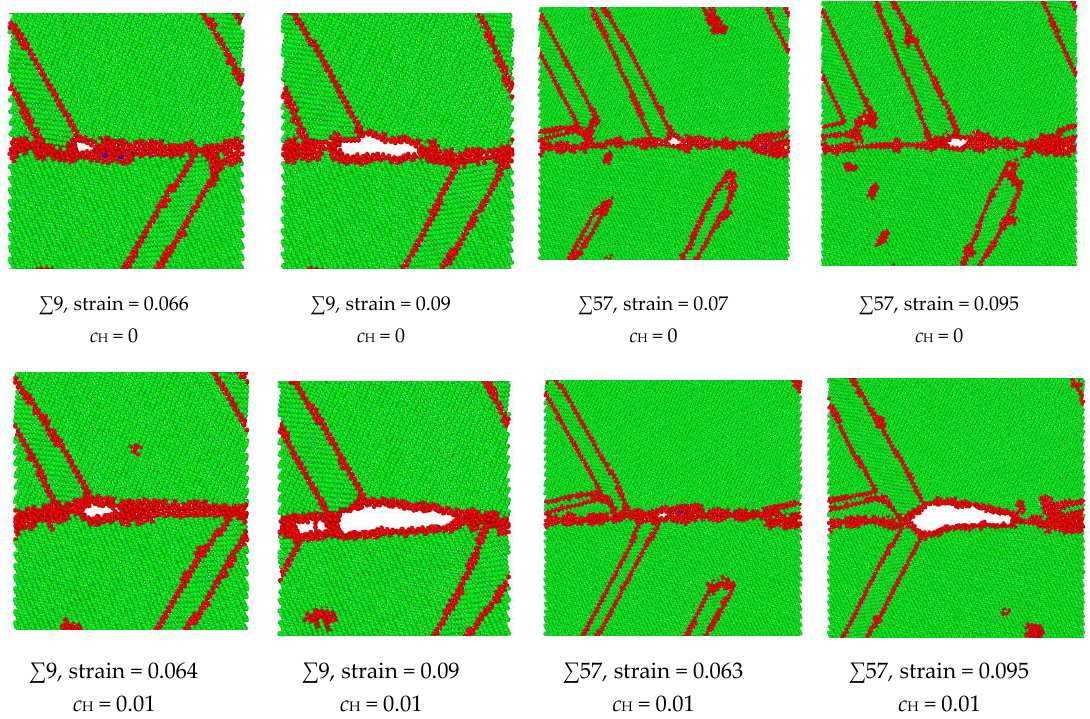
(cid:80) (cid:80) 9 and 57 GBs.